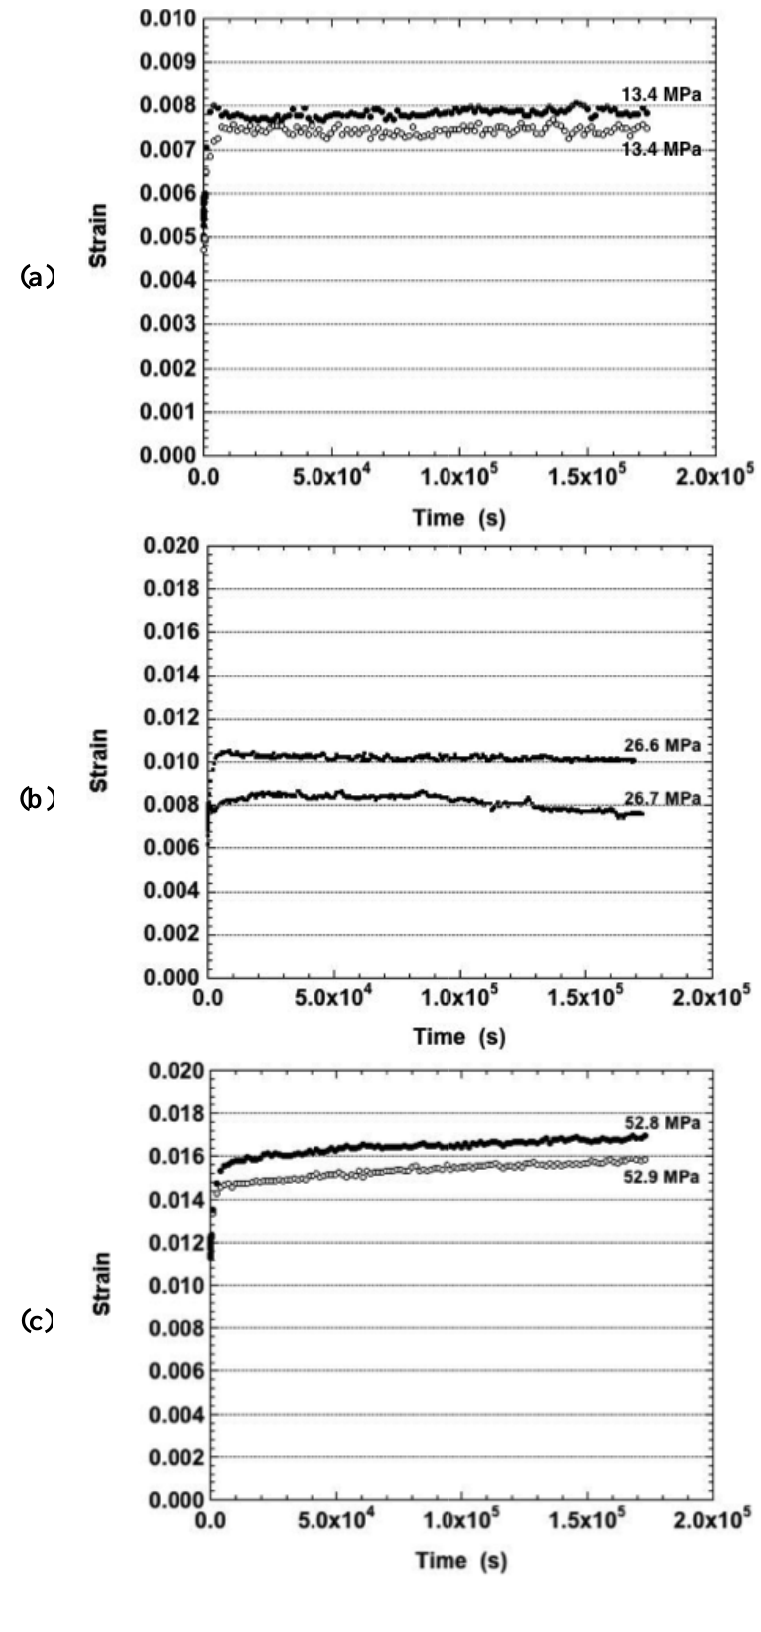
012 , 5 Ag-Bi sold e 1. Duplic cate strain-t time curves of the Sn- itsder tested in condit tion and at ature of − 2 nominal st tresses 5 °C. The .6 MPa; and ( b ) 26 MPa. Each c curve is labe eled with